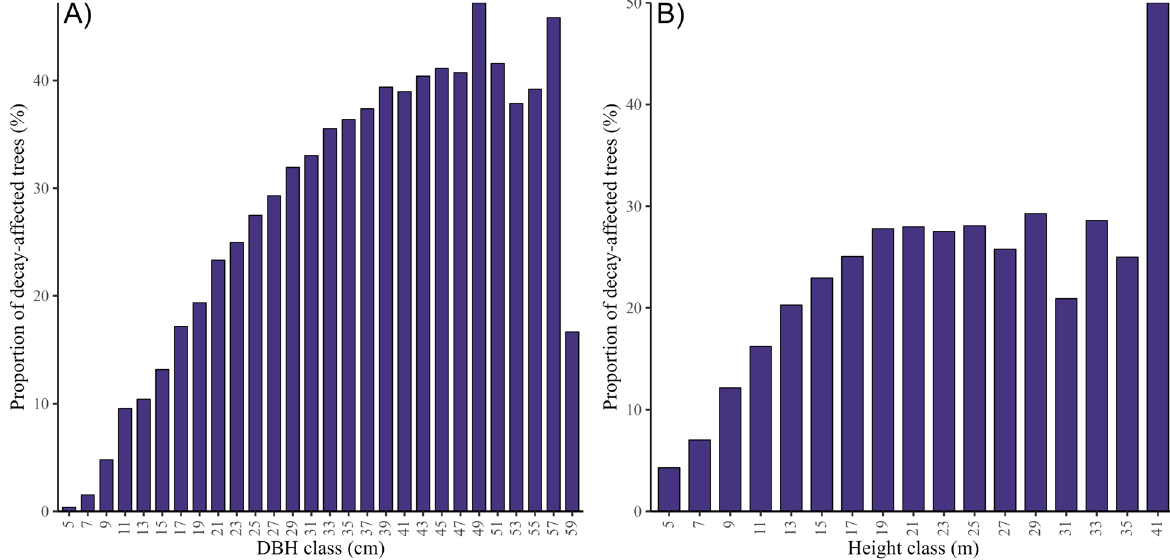
Fig. 9 Proportions of decay-affected trees by DBH ( A ) and height ( B ) classes in the harvester data. DBH, diameter at breast